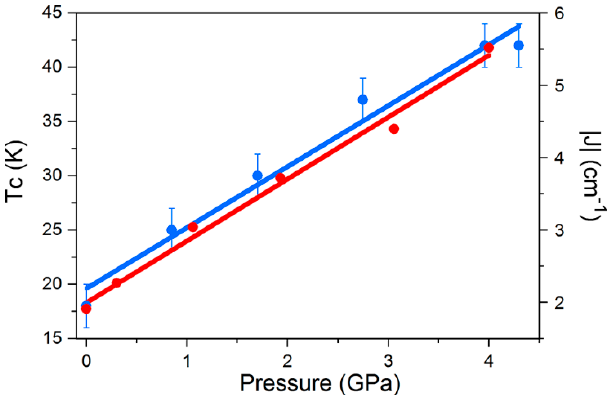
Figure 22. Magneto-structural correlations in 15 . The blue circles represent the pressure dependence of the ordering temperature, while the red circles represent the exchange interaction J . The lines represent the linear best-fit.